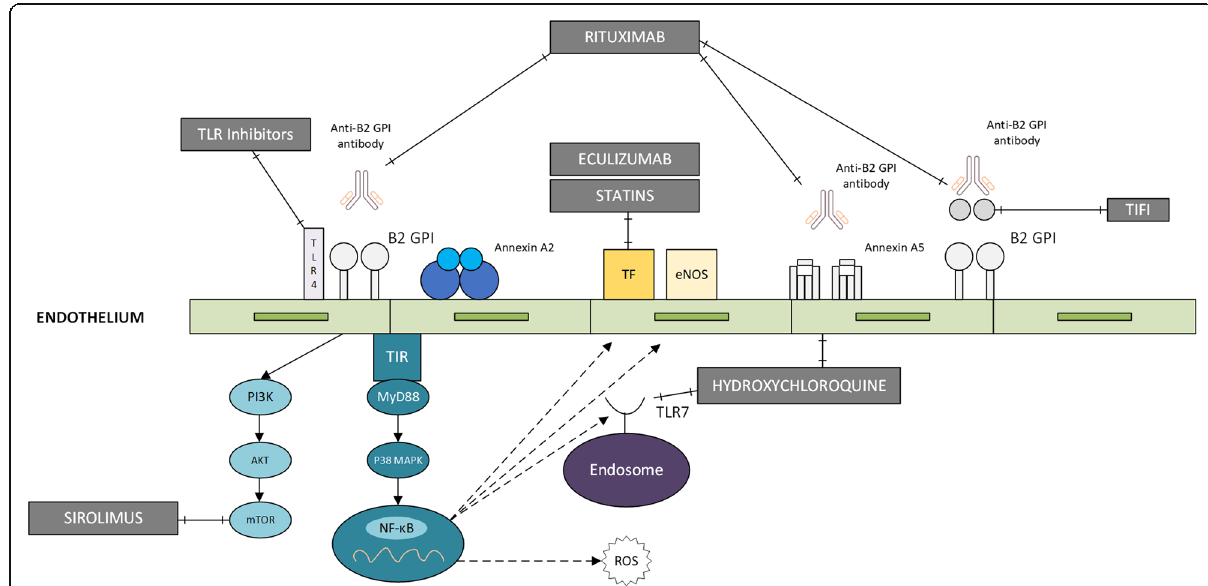
Fig. 1 Endothelial cell activation and mechanism action of potential future therapeutics in antiphospholipid syndrome [12]. β 2GPI: β 2 glycoprotein-I; TLR: toll-like receptor; TF: tissue factor; eNOS: endothelial nitric oxide synthase; mTOR: mammalian target of rapamycin; ROS: reactive oxygen species; NF κ B: nuclear factor kappa-light-chain-enhancer of B